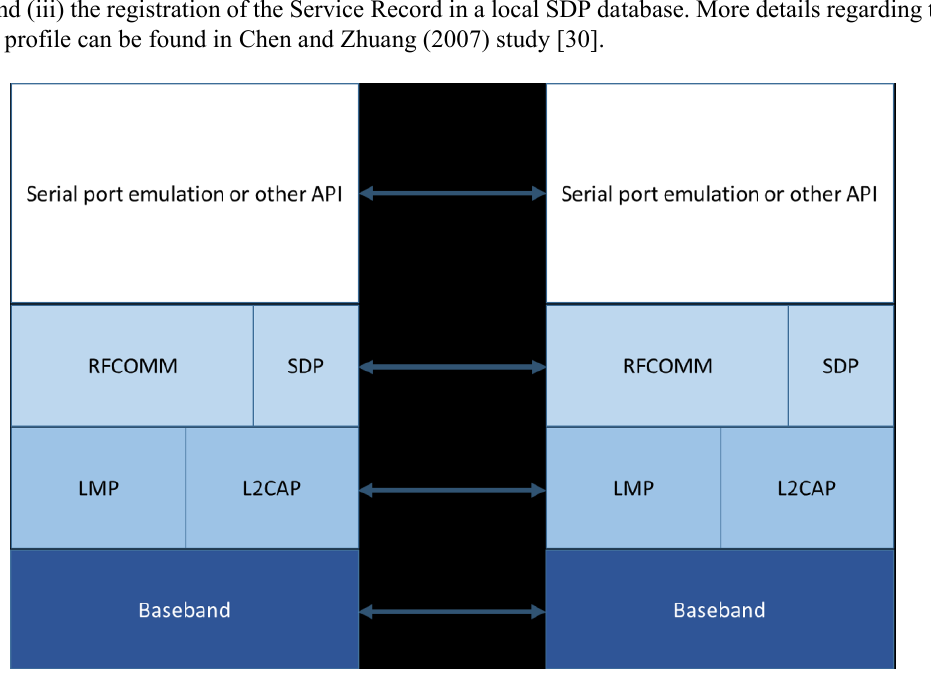
Figure 2. Bluetooth SPP profile and the interacting